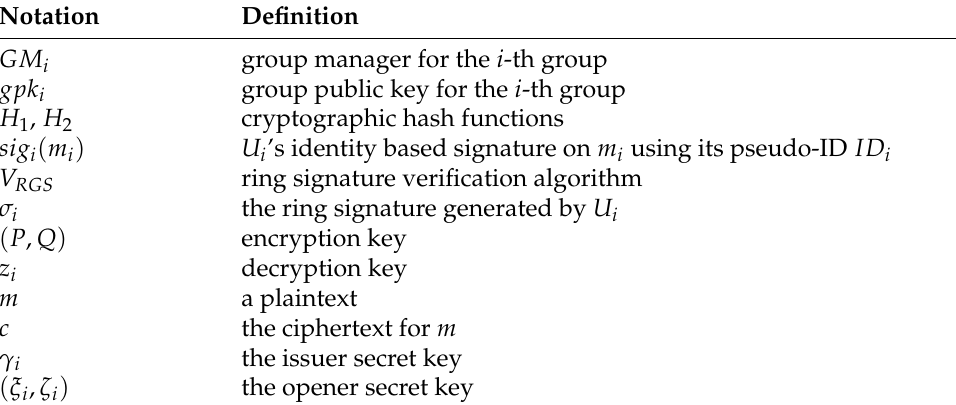
Table 1. List of